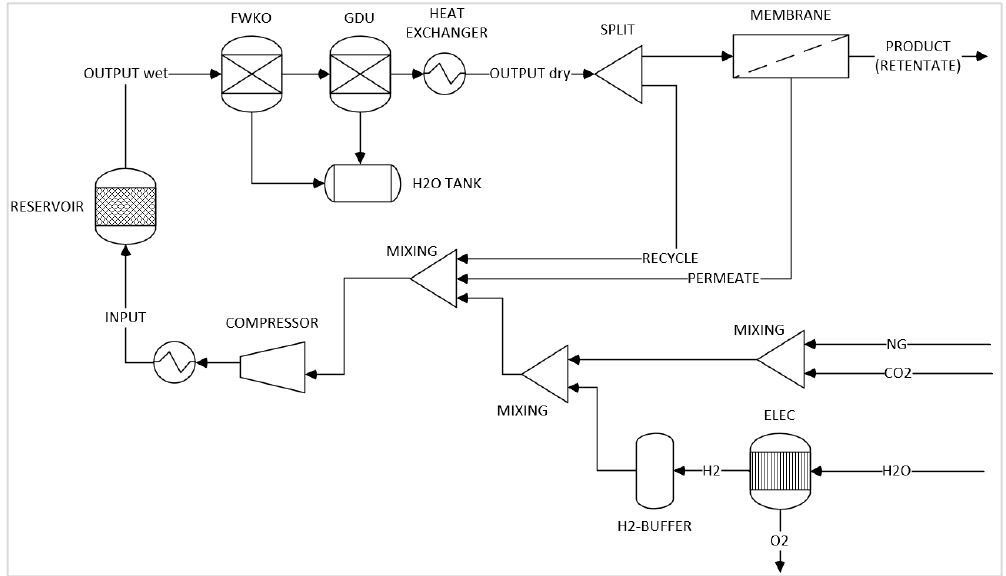
Figure 2. Simplified version of Aspen Plus ® flowsheet for CYCLE mode.